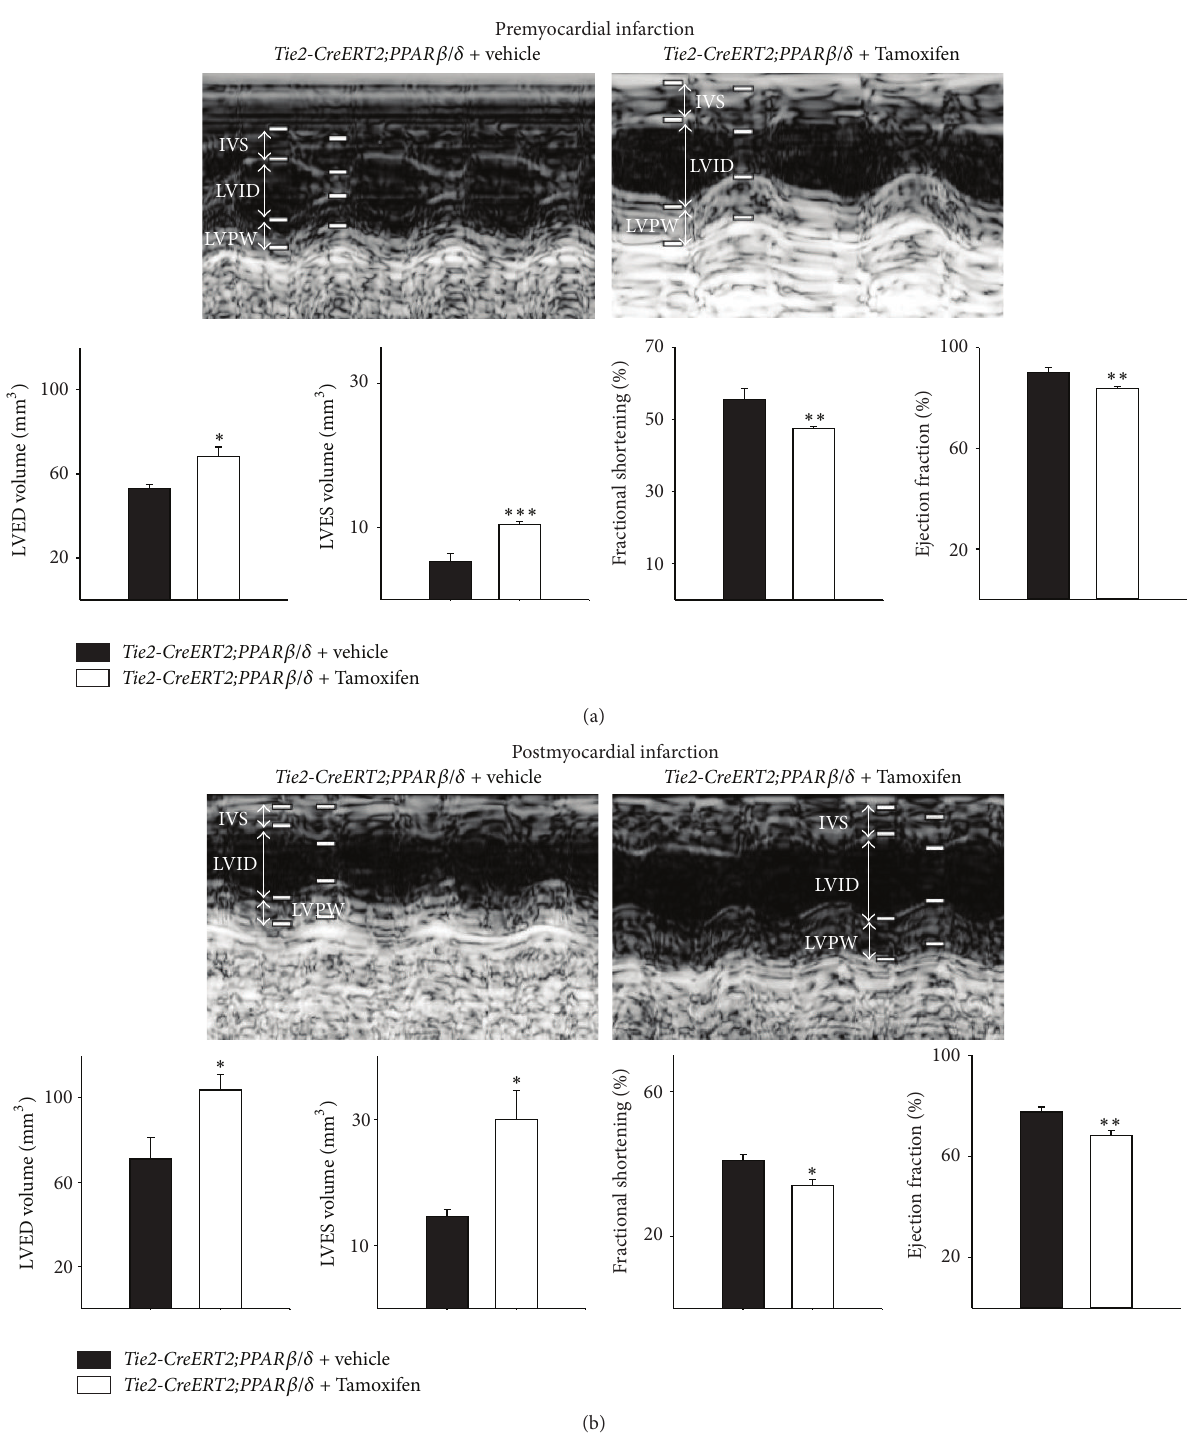
Figure 6: Impaired cardiac function upon vascular-specific PPAR 𝛽 / 𝛿 overexpression, which worsens after myocardial infarction. (a) Echocardiographic examination indicates increased systolic and diastolic volumes, a reduced fractional shortening, and a decreased ejection fraction in animals with vessel-specific overexpression of PPAR 𝛽 / 𝛿 , which becomes more evident after myocardial infarction (b) ( Tie2- CreERT2;PPAR 𝛽 / 𝛿 + Tamoxifen, 𝑛 = 8 , and Tie2-CreERT2;PPAR 𝛽 / 𝛿 + vehicle, 𝑛 = 5 ). IVS: interventricular septum; LVID: left ventricular internal diameter; LVPW: left ventricular posterior wall. Data are means ± SEM. ∗ 𝑝 < 0.05 , ∗∗ 𝑝 < 0.01 , and ∗∗∗ 𝑝 < 0.001